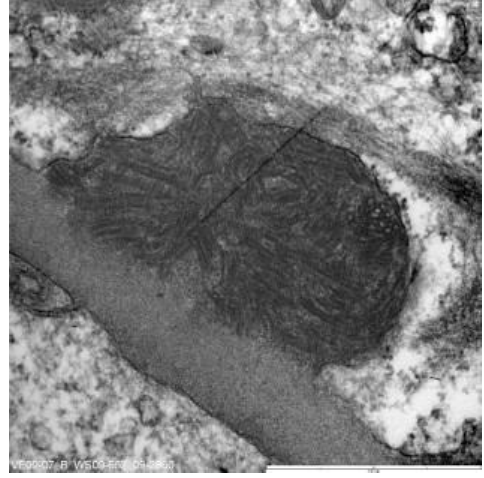
FIGURE 7. EM: subepithelial deposit with microtubule ultrastructure.